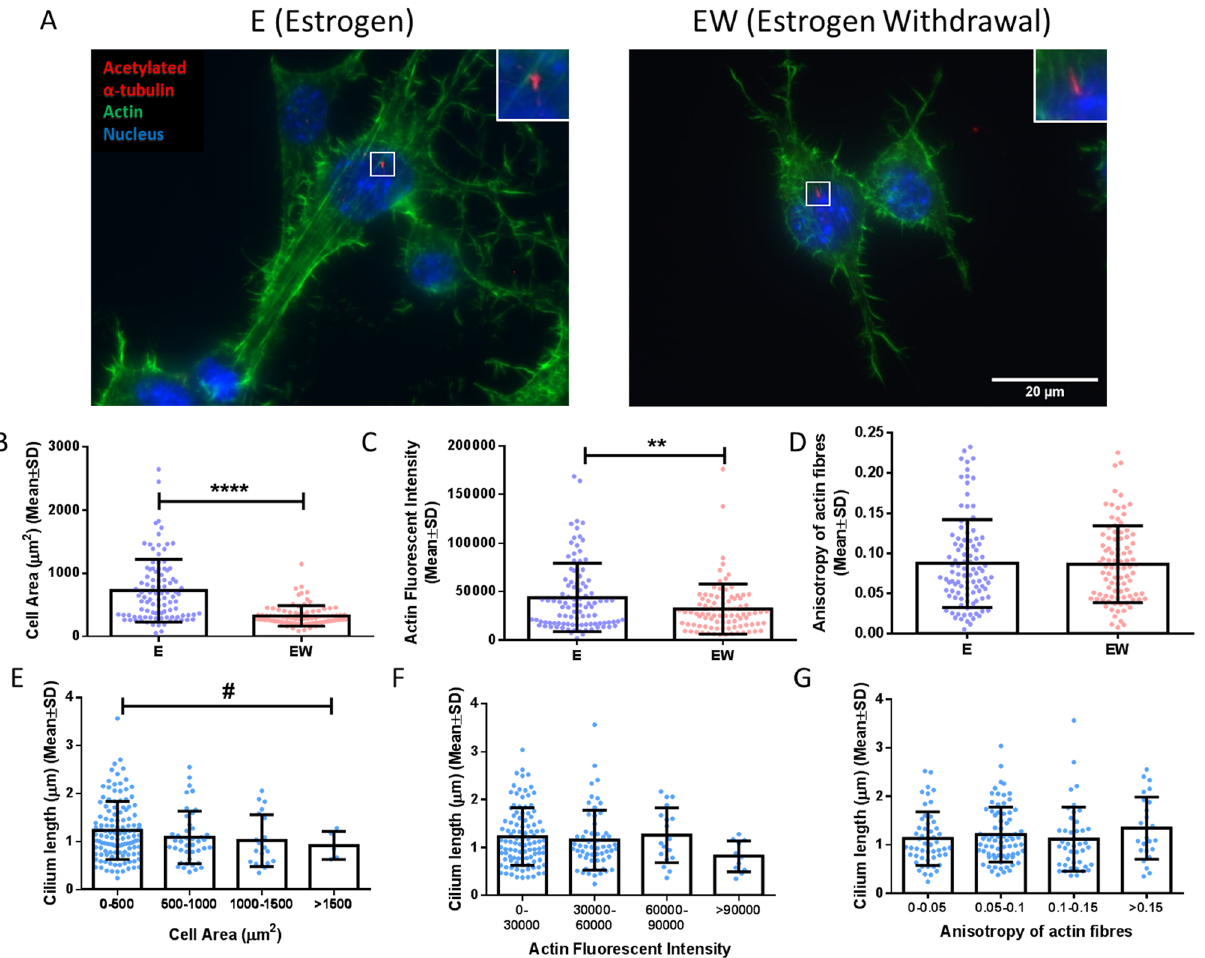
Figure 3. The effect of estrogen withdrawal on the role of the actin cytoskeleton in primary cilium dynamics. (A) Immunocytochemistry images showing acetylated α-tubulin, actin cytoskeleton, and nuclei staining (N = 3, n ≥ 92 cells per group). Quantification of the images showing (B) cell area, (C) actin fluorescent intensity, and (D) anisotropy of actin fibres. Quantification of the images to determine trend between primary cilium length and (E) cell area, (F) actin fluorescent intensity, and (G) anisotropy of actin fibres. (Student’s t-test, **p < 0.01, ****p < 0.0001. One-way ANOVA to determine trend between groups, #p <